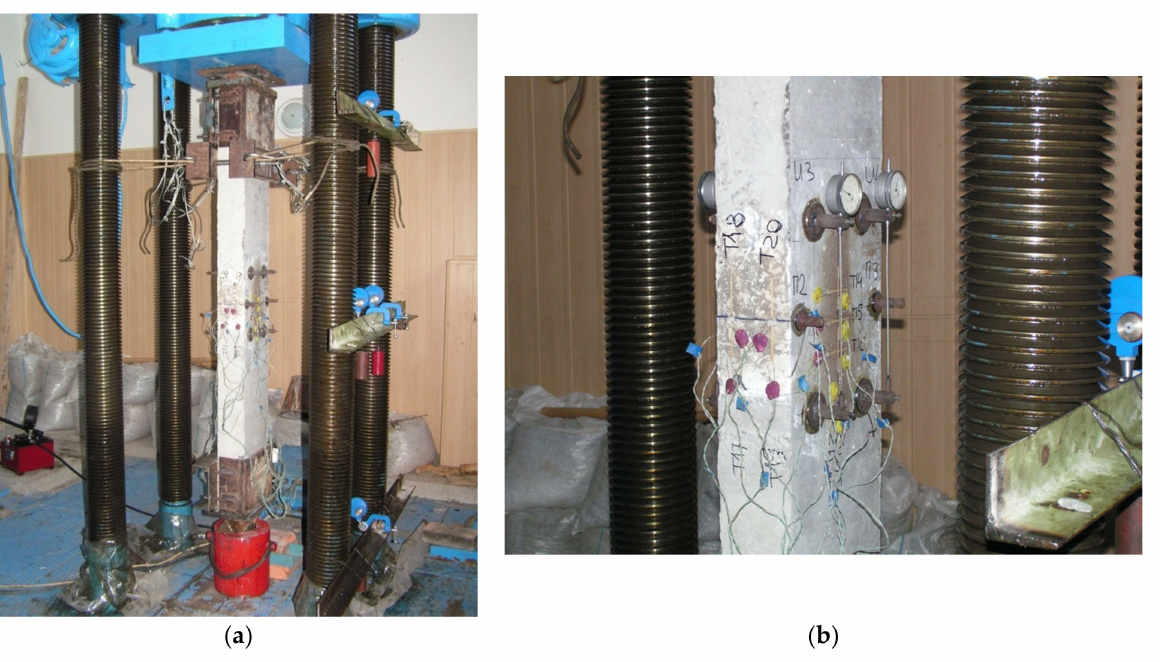
Figure 3. Tests of prototypes on a power stand: ( a ) general view; ( b ) measuring sensors (T14-T16 transverse deformation sensors, T17-T20 longitudinal deformation